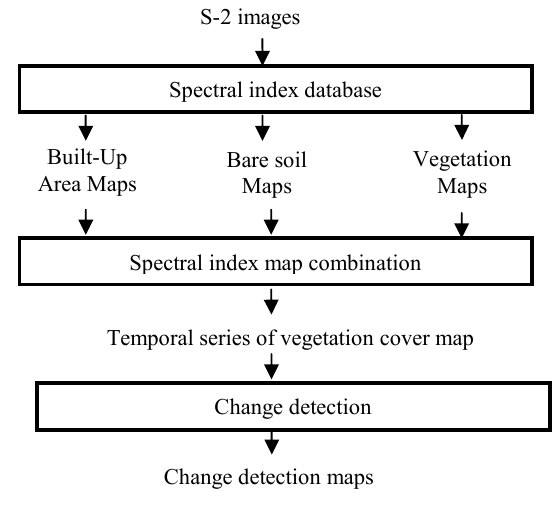
Figure 1. Processing chain